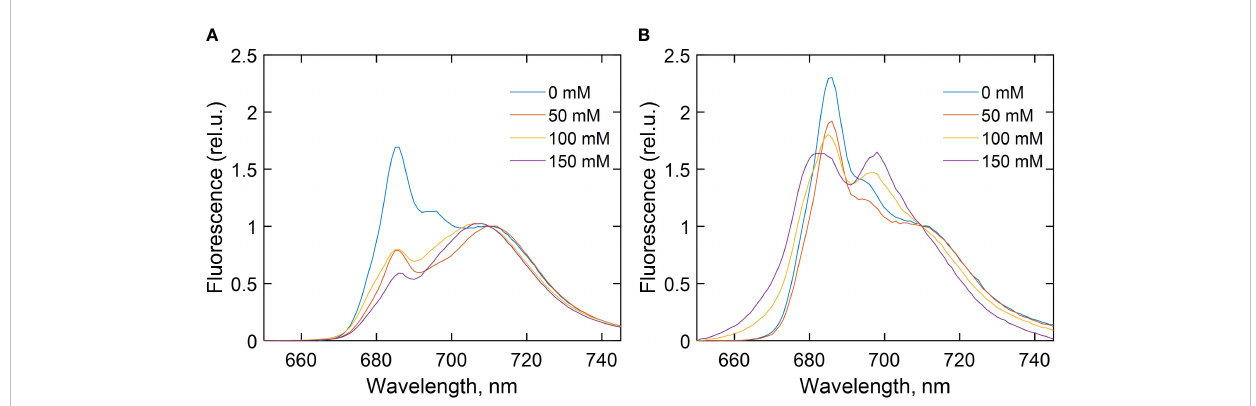
FIGURE 2 77 K fl uorescence emission spectra of (A) wild type (WT), (B) state transition kinase 7 ( stt7) strains of C. reinhardtii cells grown in media containing different concentrations of NaCl as indicated. The spectra are averages from at least three measurements on different batches and are normalized at 710 nm. For further details, see experimental procedures.